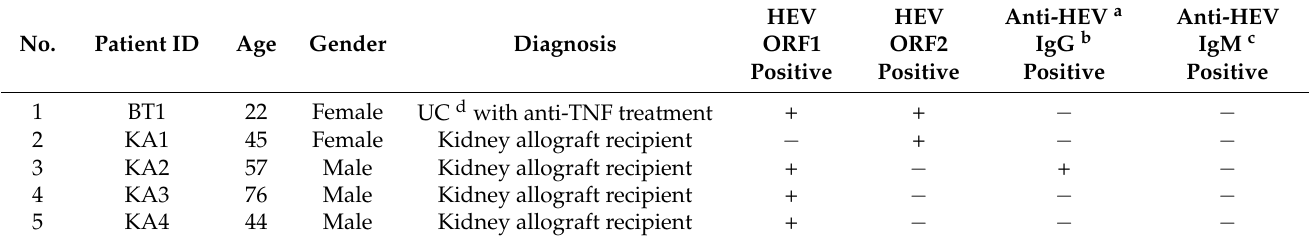
Table 5. Patients tested HEV